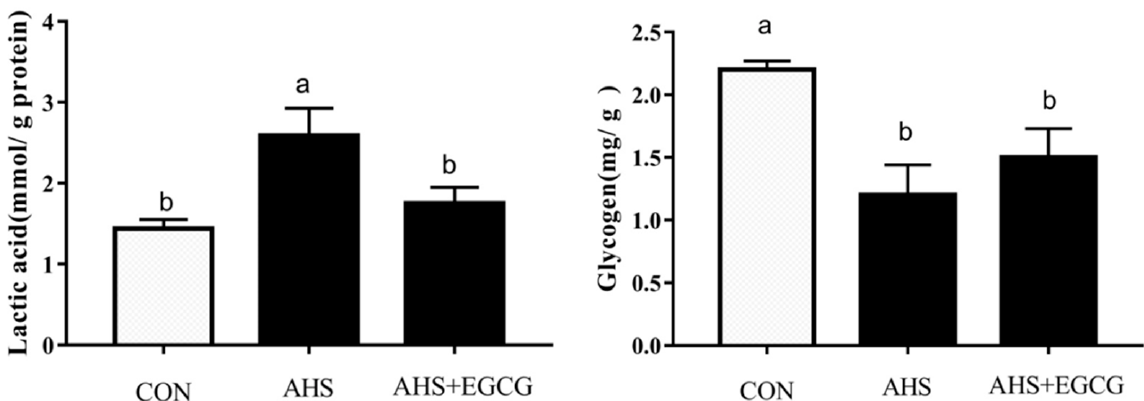
Figure 1. Effect of EGCG on lactic acid and glycogen contents in the muscle of broilers subjected to acute heat stress. a,b Values without common superscripts in the same row differ significantly ( p < 0.05). CON, control group; AHS, acute heat stress group; AHS + EGCG, acute heat stress + epigallocatechin gallate group.